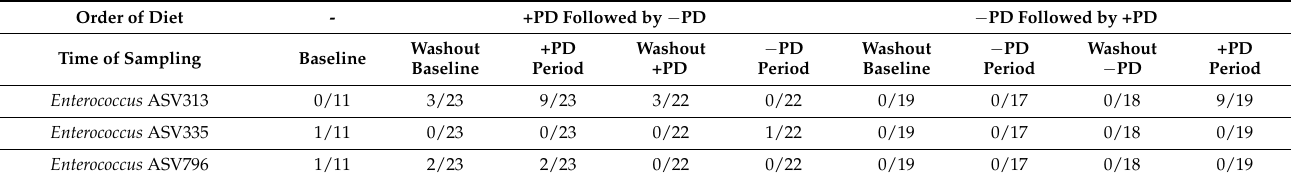
Table 3. Faecal Enterococcus